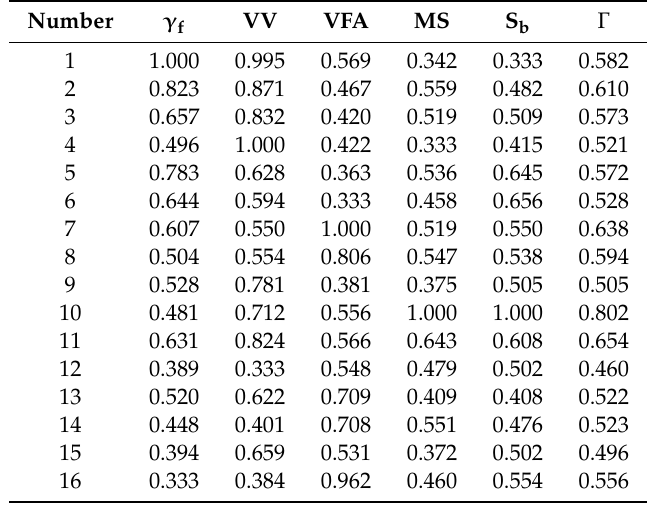
Table 9. Analysis results of grey correlation degree of objective function.